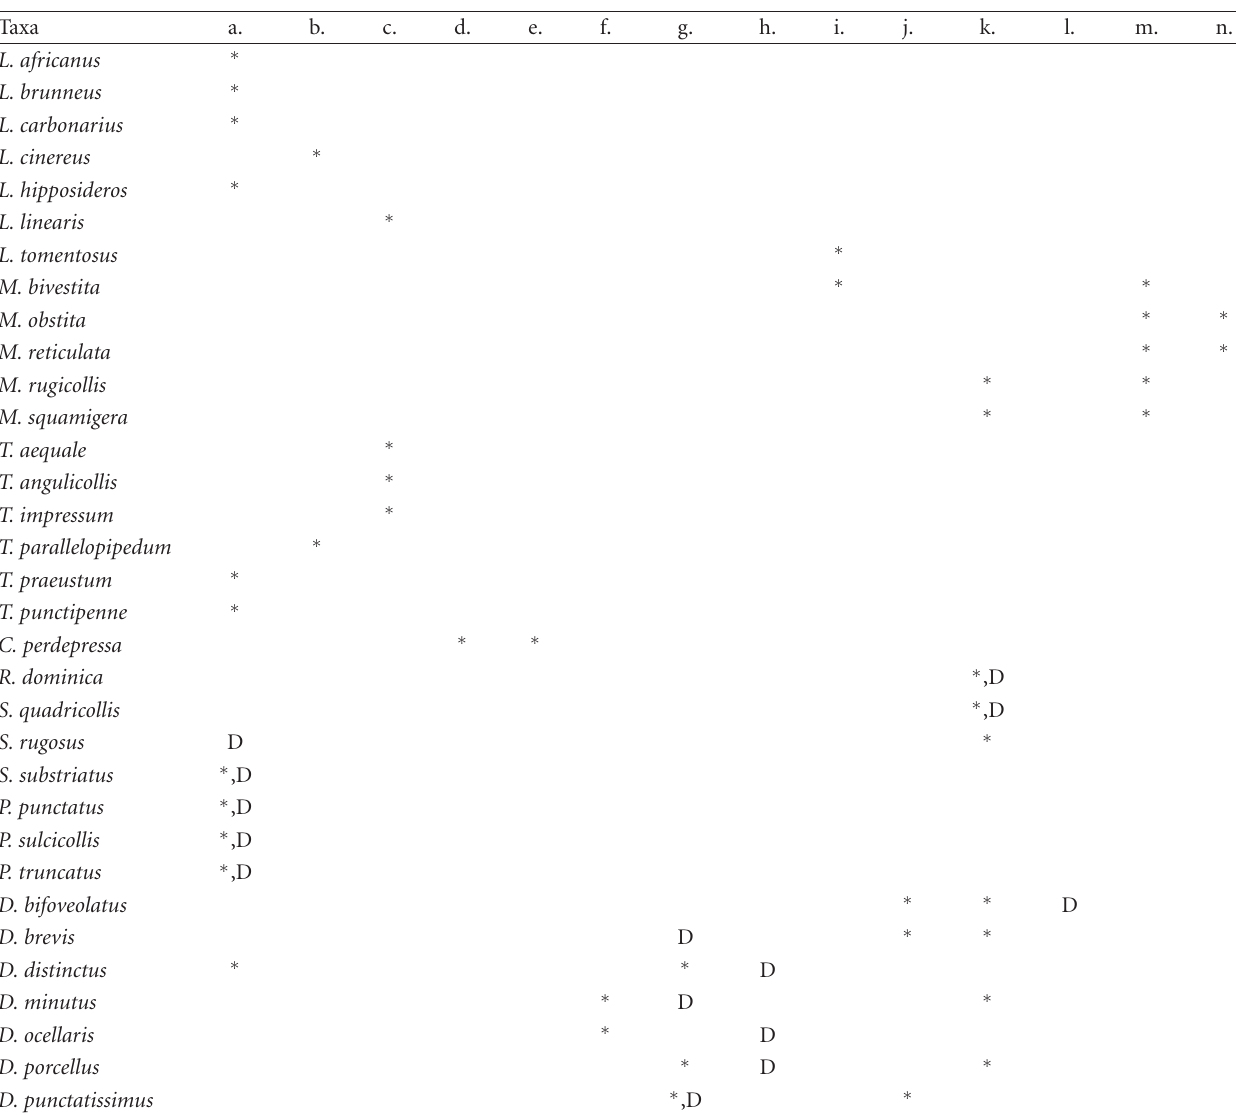
Table 2: Distribution of the di ff erent types of hairs ( ∗ : appear on elytra, D: appear on decilivity). Taxa